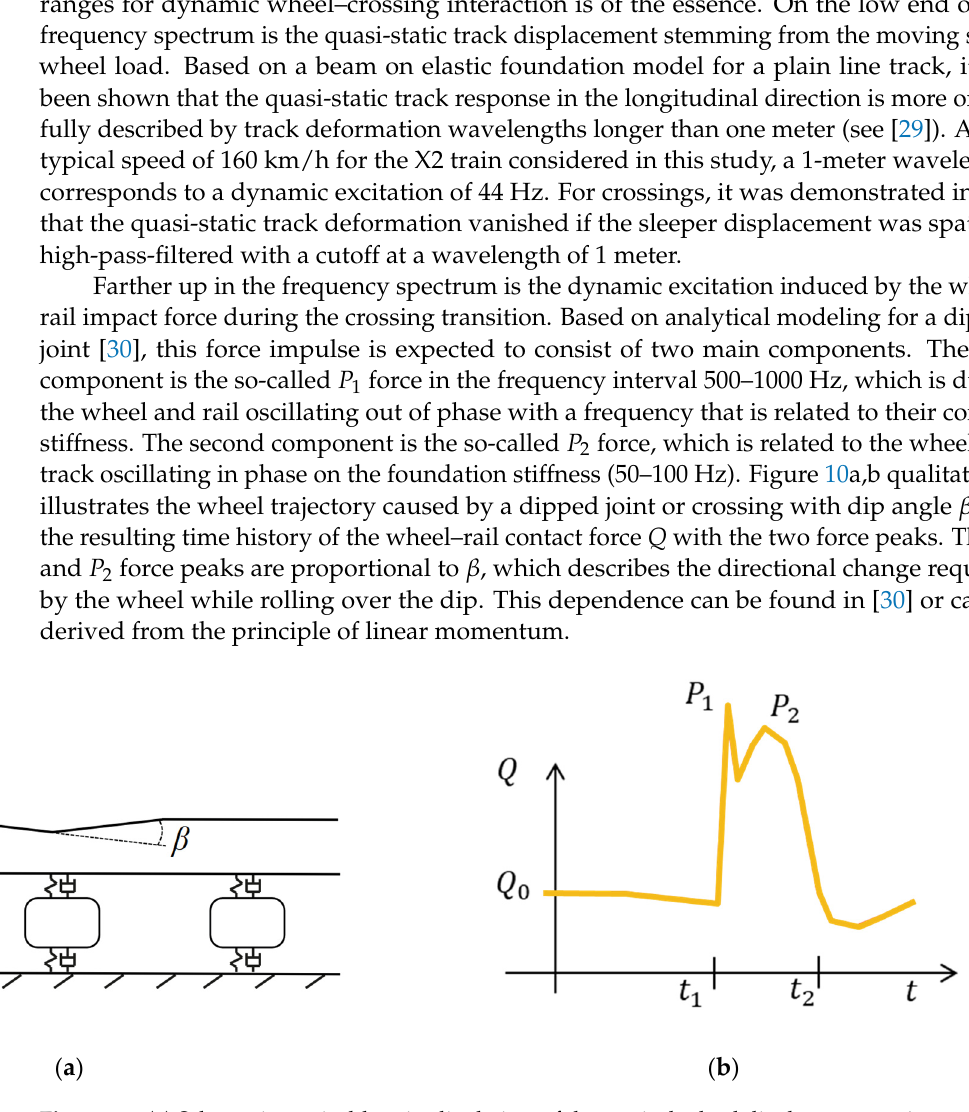
Figure 10. ( a ) Schematic vertical-longitudinal view of the vertical wheel displacement trajectory over a dipped joint or crossing. ( b ) Qualitative illustration of the corresponding time history of the vertical wheel–rail contact force.